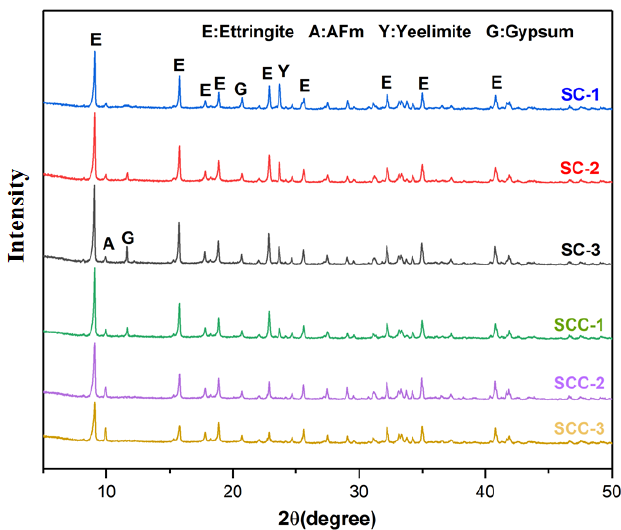
Figure 6. XRD curves of samples SC1-SC3 and SCC1-SCC3 at 3 days of age.